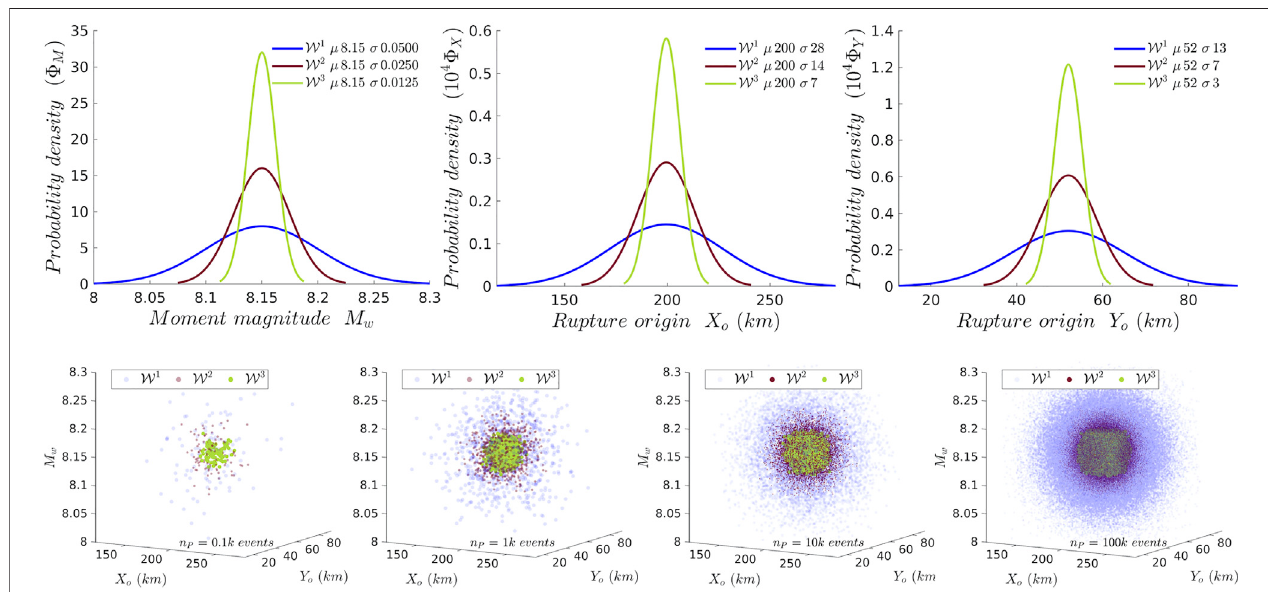
FIGURE 6 | The three stages of tsunami warning. Top row: The probability distributions of the input parameters - magnitude M w (left) , rupture origin coordinates X o (middle) and Y o (right) . The standard deviation of the Gaussian distributions decreases by a factor of 2 as warning stages progress. Bottom row: The samples drawn from these three distributions, successively increasing in order from n P (cid:2) 0.1 k in the left to n P (cid:2) 100 k in the